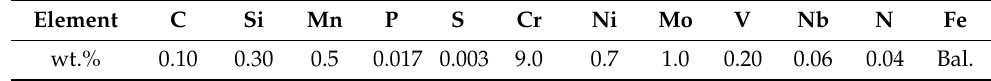
Table 1. The chemical composition (wt.%) of the P91 steel.